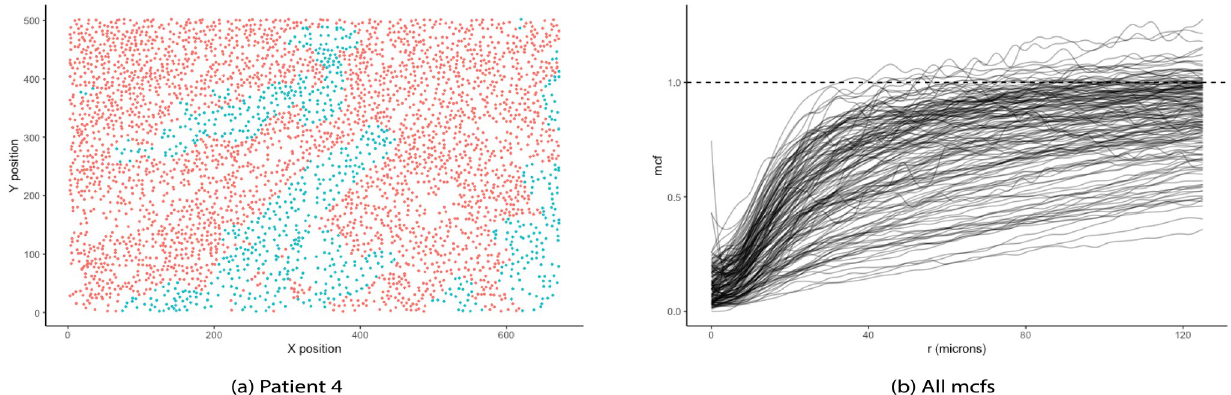
Fig 3. NSCLC dataset. (A) Representative image illustrating locations of stromal (red) and tumor cells (turquoise). (B) Mark connection functions (mcf) for the tumor—stromal cell distributions for all subjects. Dashed horizontal line represents mcf under complete randomness. Mcf values below 1 indicate strong clustering of cells of same type, while values above 1 suggest higher level of mixing in of the two cell types.